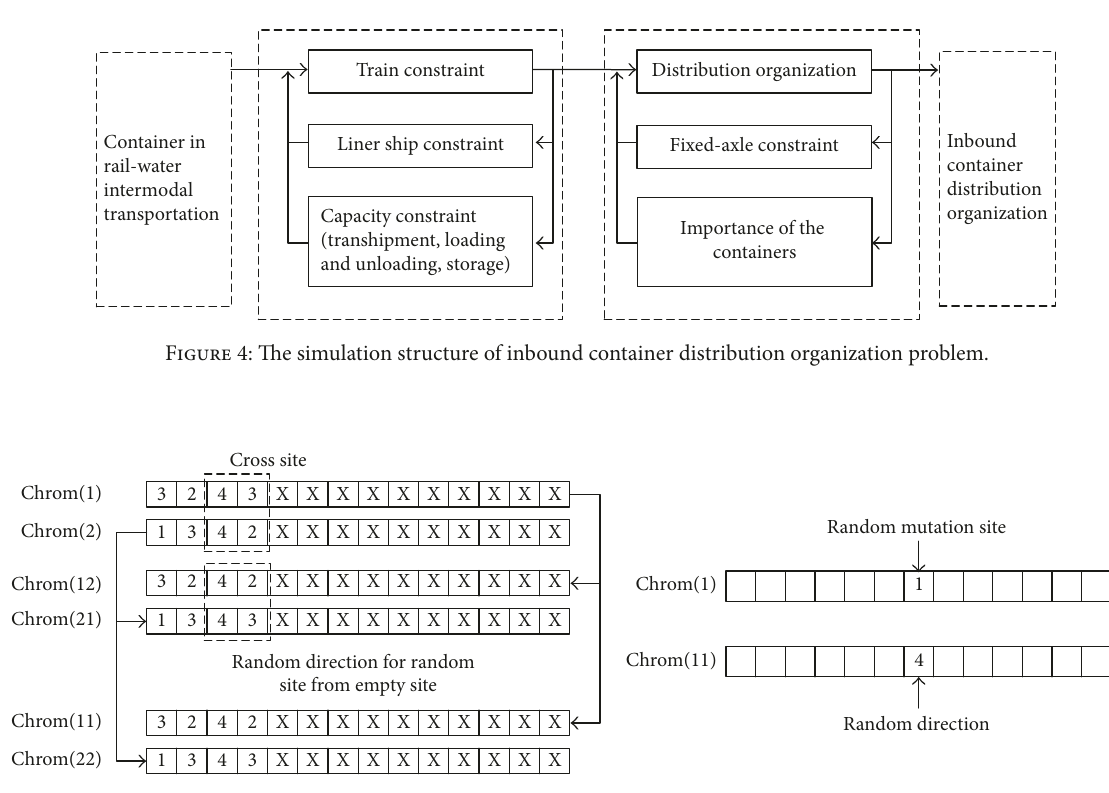
Figure 5: Schematic diagram of crossover operation and mutation